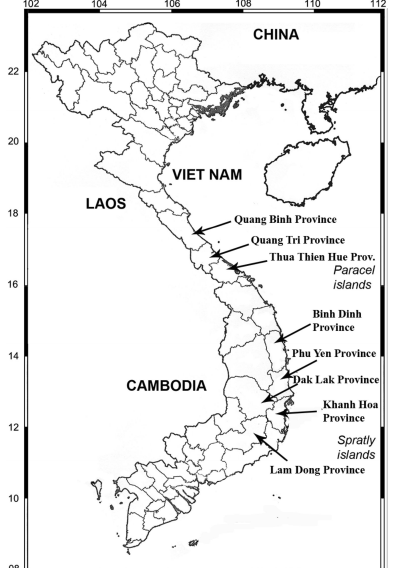
Figure 1. Geographical position of the studied